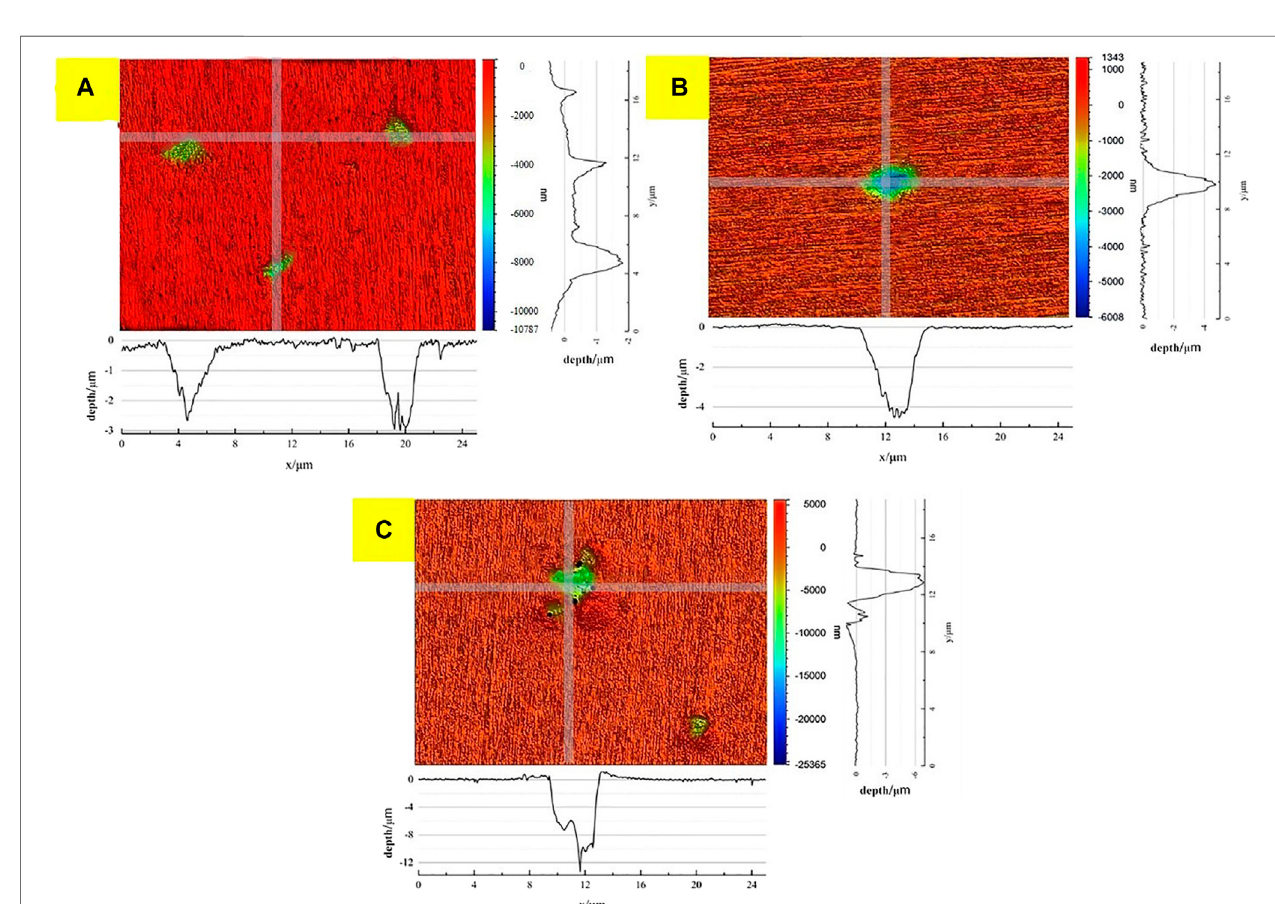
FIGURE 8 | Outline of the corrosion pit after 30, 60, and 180 days of corrosion. (A) 30 days, (B) 60 days, and (C) 180 days.